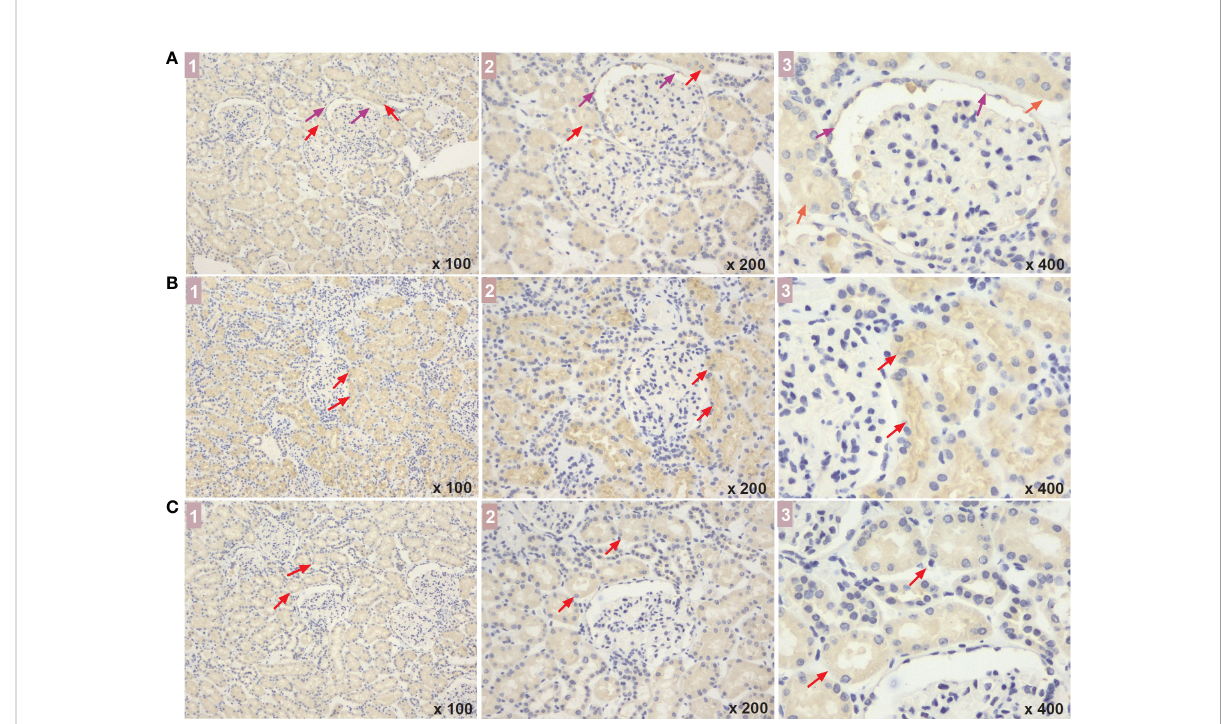
FIGURE 6 The expressed sites of NBR1, VPS37A, and ATG4B in renal tissue of DM patients. (A-C) show the NBR1, VPS37A, and ATG4B expression, respectively, and the marks of 1, 2, and 3 represent the different magni fi cation time under a light microscope (x 100, x 200, and x 400, respectively). What marked with the red arrows means the expressions in renal tubular cells, and the expressions in the cystic wall of renal glomeruli was marked with the purple arrows. DM, diabetes